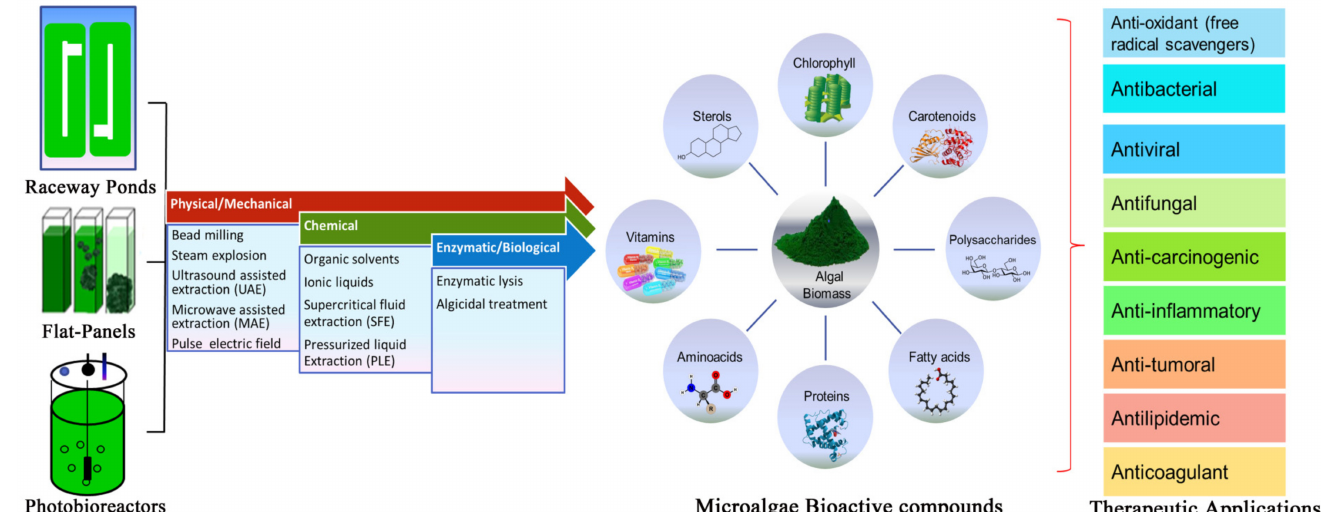
Figure 1. Stepwise illustration of algal biorefinery and their therapeutic